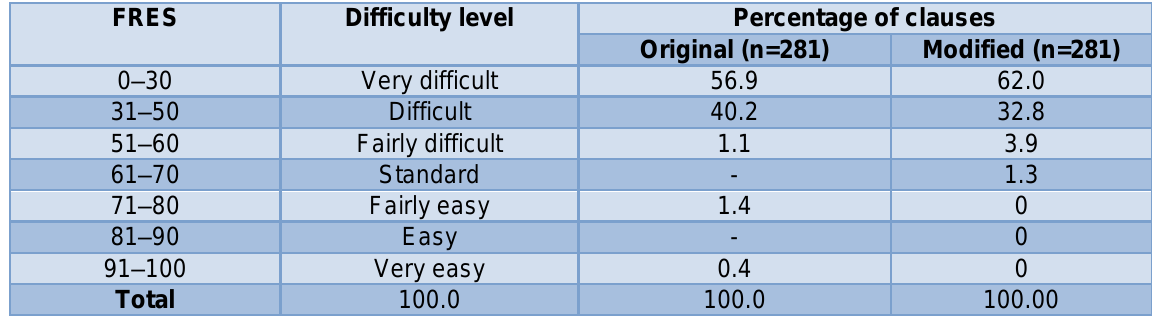
Table 2 Readability levels of original and